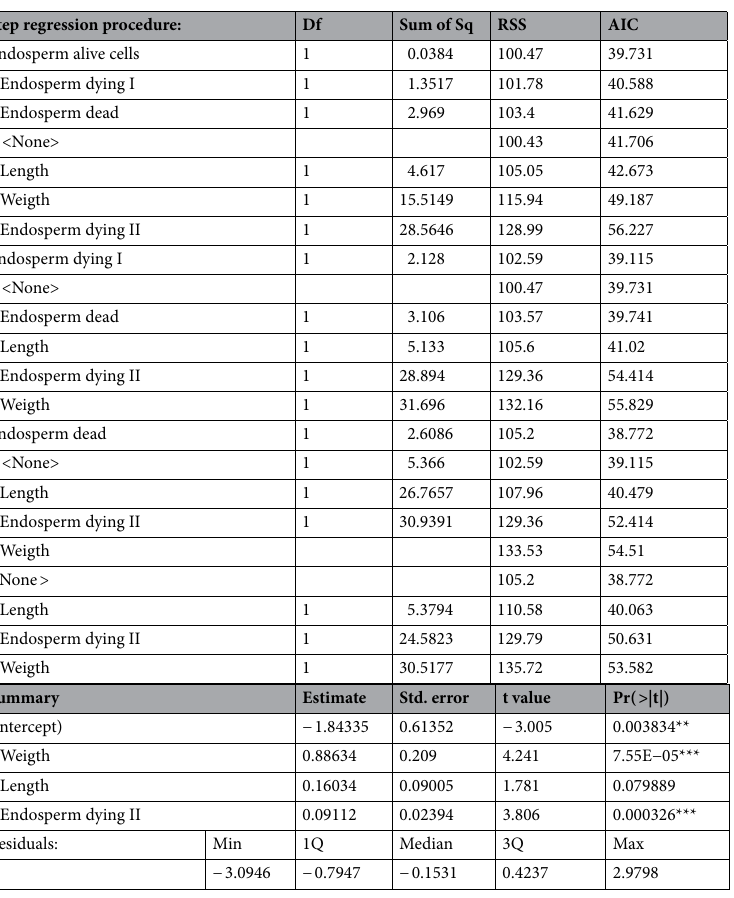
Table 3. Variables significantly dependent on the stage of embryo development according to the model obtained by multiple stepwise linear regression on the basis of 66 data set, residual standard error: 1.303 on 62 degrees of freedom, F-statistic: 11.44 on 3 and 62 DF, p value: 4.557e-06, significance codes: ‘***’ 0.001 ‘**’ 0.01 ‘*’ 0.05 ‘ . ’